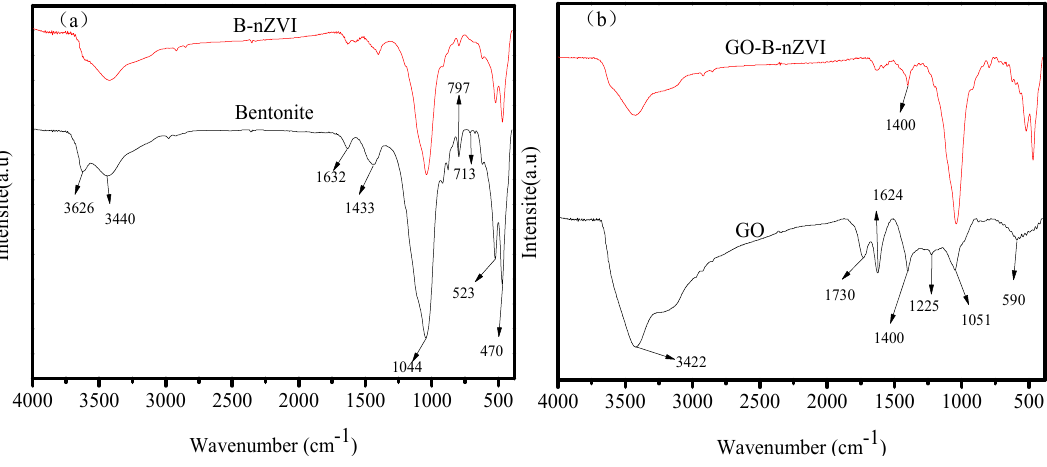
Figure 1. Fourier transform infrared spectroscopy (FTIR) spectra of bentonite, B-nZVI, GO, and GO-B-nZVI: ( a ) bentonite and B-nZVI, ( b ) GO and GO-B-nZVI.